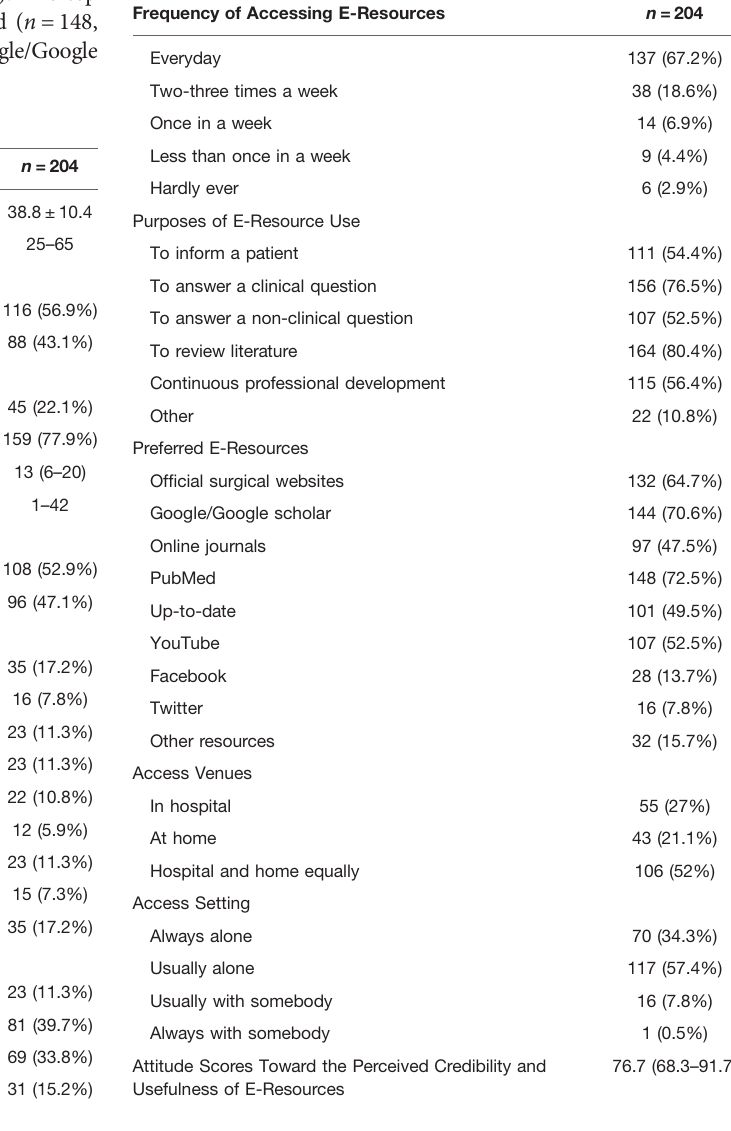
TABLE 2 | Internet resource use and attitude reported by participants and preferred sites for continuous professional